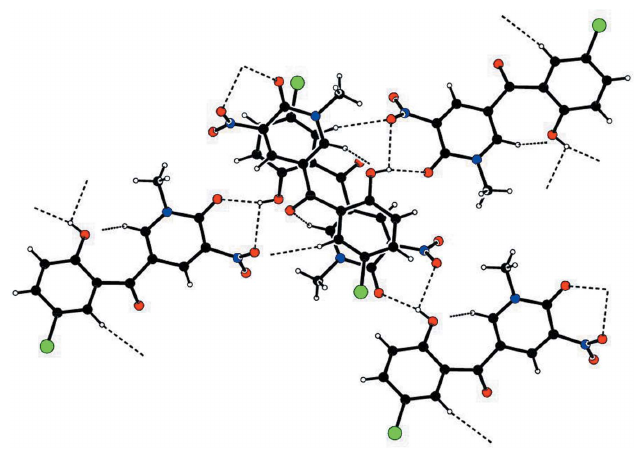
Figure 2 Hydrogen-bonding network, viewed along the a axis. Hydrogen bonds (see Table 1) are shown as dashed lines.